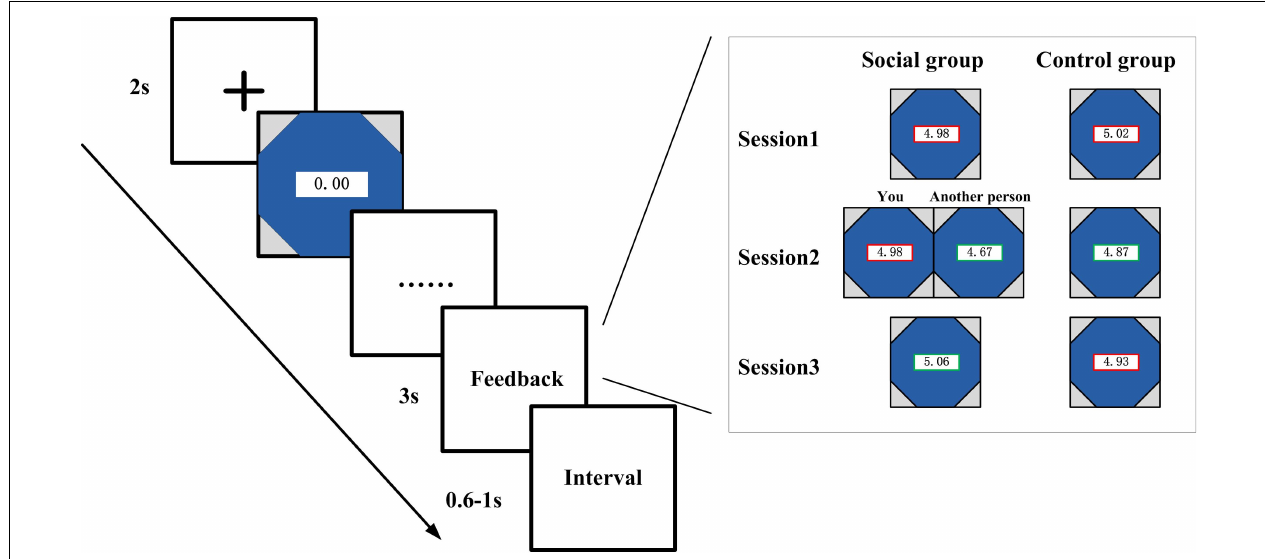
FIGURE 1 | Schematic of the experimental task. As a between-subject design, paired subjects were instructed to play an adapted version of the stopwatch (SW) task. In the treated group, the subjects observed the outcome of paired others in the second session in addition to their own outcome, while the subjects in the control group only see their own performance throughout the whole three